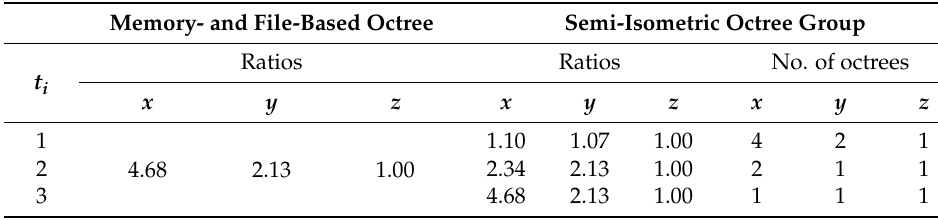
Table 4. Comparison of leaf node dimensions of Data 2.